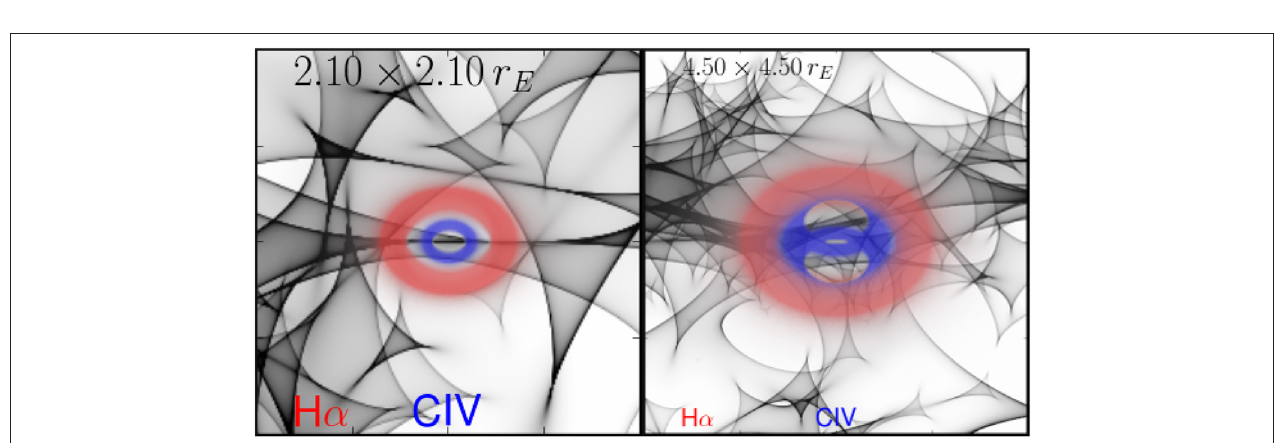
FIGURE 4 | Examples of models of the CIV and H α BELRs and their location on the caustic network that simultaneously fit the microlensing observables µ cont , µ BLR , RBI , WCI measured for both the CIV and H α lines in the lensed quasar Q2237 + 030. Left : Keplerian disks for both H α and CIV BELRs. Right : Keplerian disk for H α and polar wind for CIV. All models are seen under intermediate inclination, i = 44 ◦ . The CIV emitting region (in blue) is more compact than the H α emitting region (in